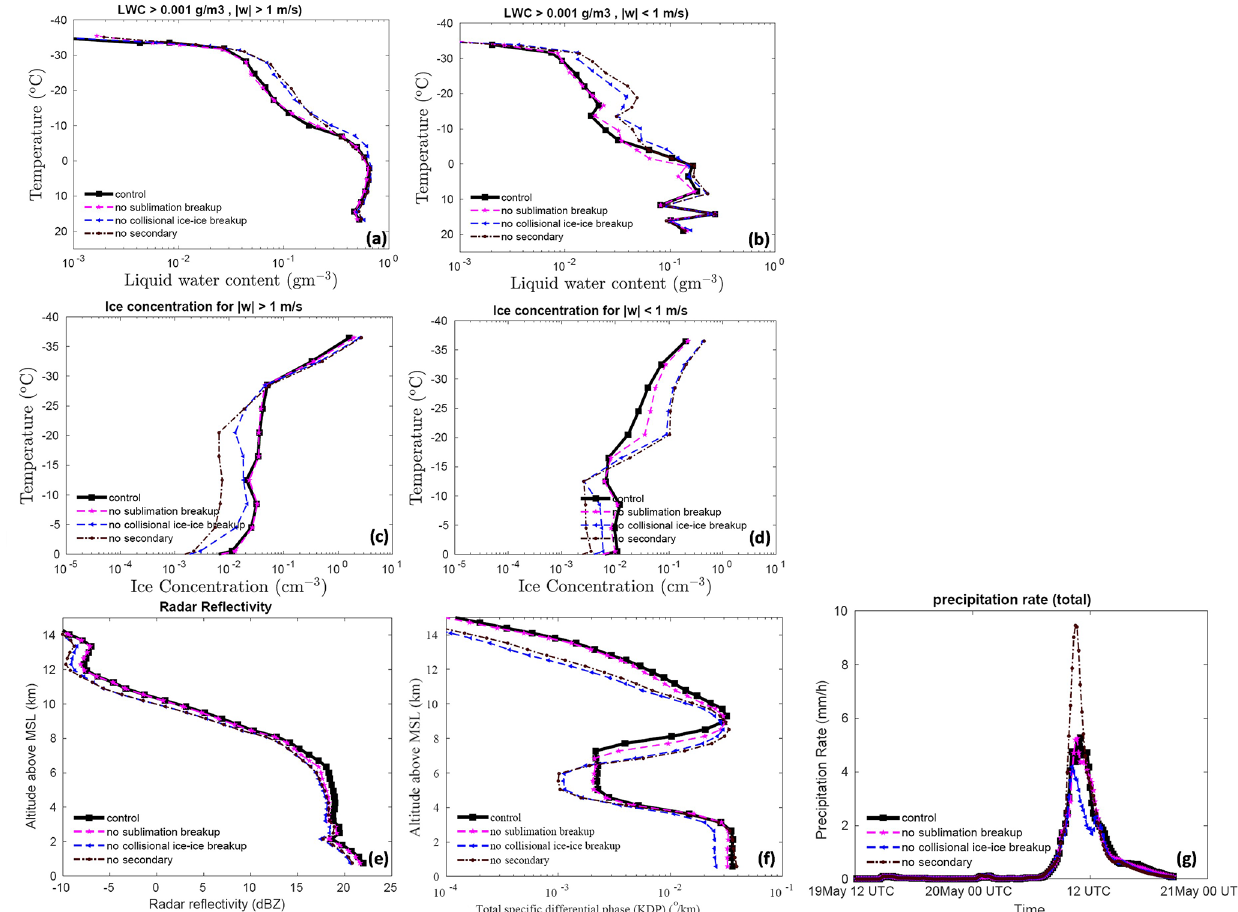
Figure 9. Temperature dependence of the liquid water content in (a) the convective and (b) the stratiform region for the control simulation and various sensitivity runs involving SIPs. The ice number concentration is also shown for the (c) convective and (d) stratiform regions. The averaging conditions are mentioned at the top of each figure. The vertical profiles of (e) radar reflectivity and (f) total specific differential phase are also shown for the same simulations. (g) The temporal evolution of the total surface precipitation rate averaged over the domain is also shown. All the vertical profiles shown here are averaged for the whole